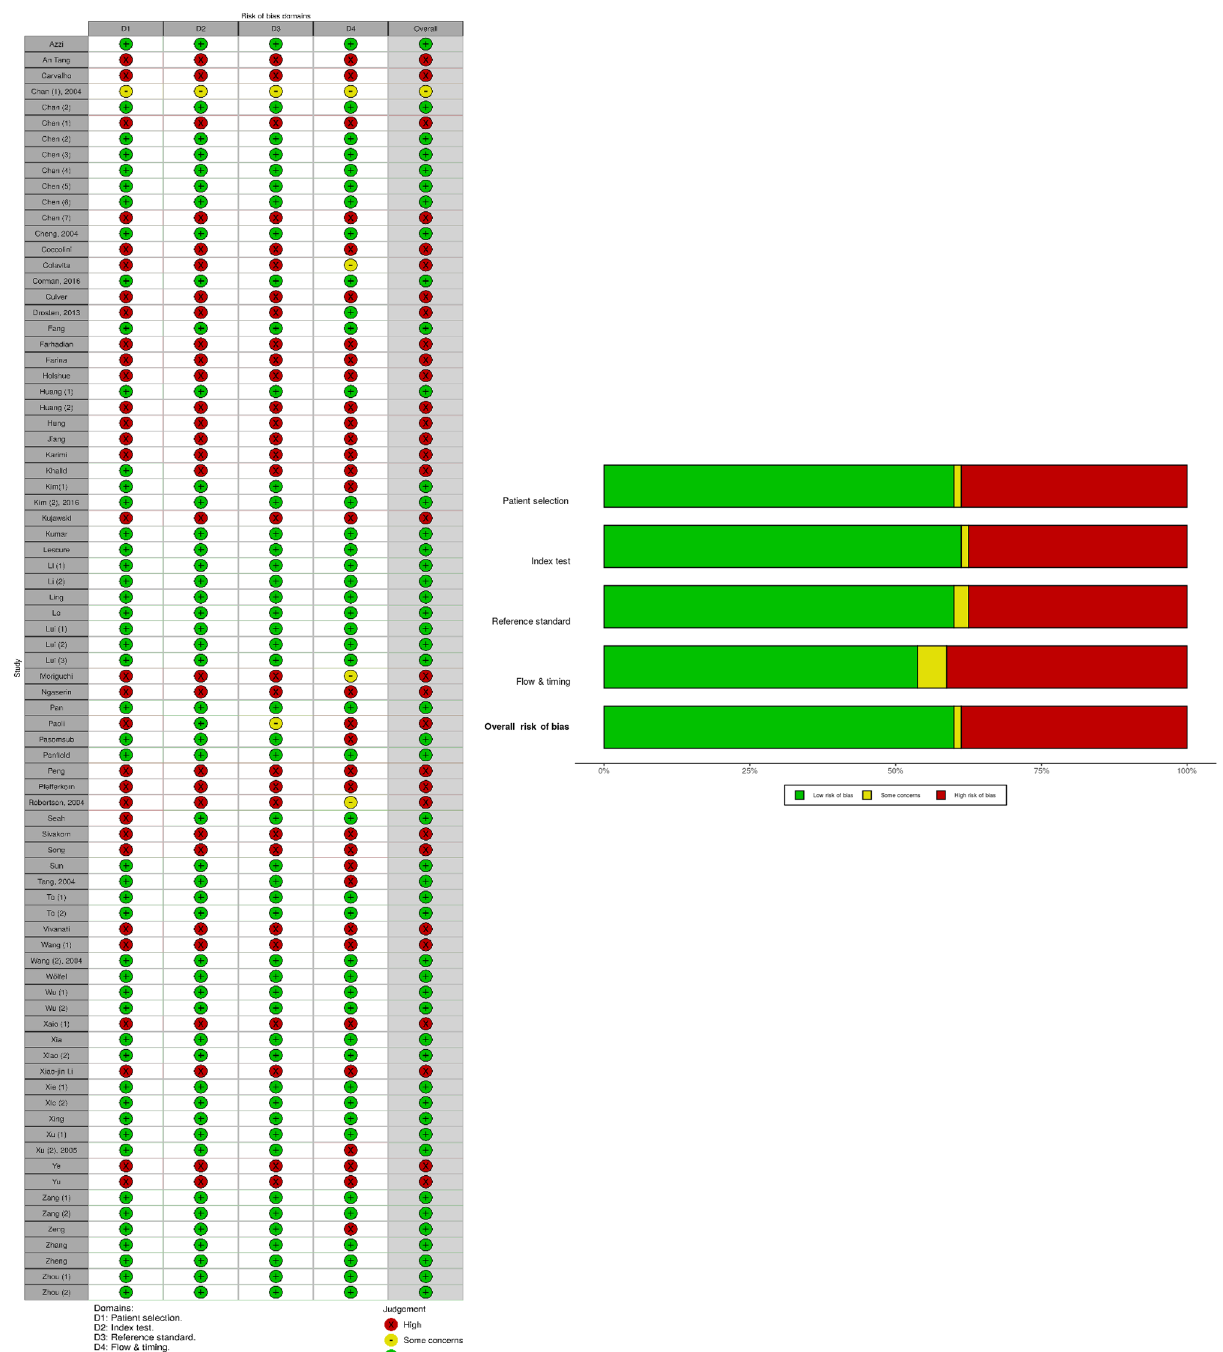
Figure 4. Risk of Bias assessment of included studies using QUADAS 2 tool displayed (traffic light plot) with bias summary (non-weighted). Study